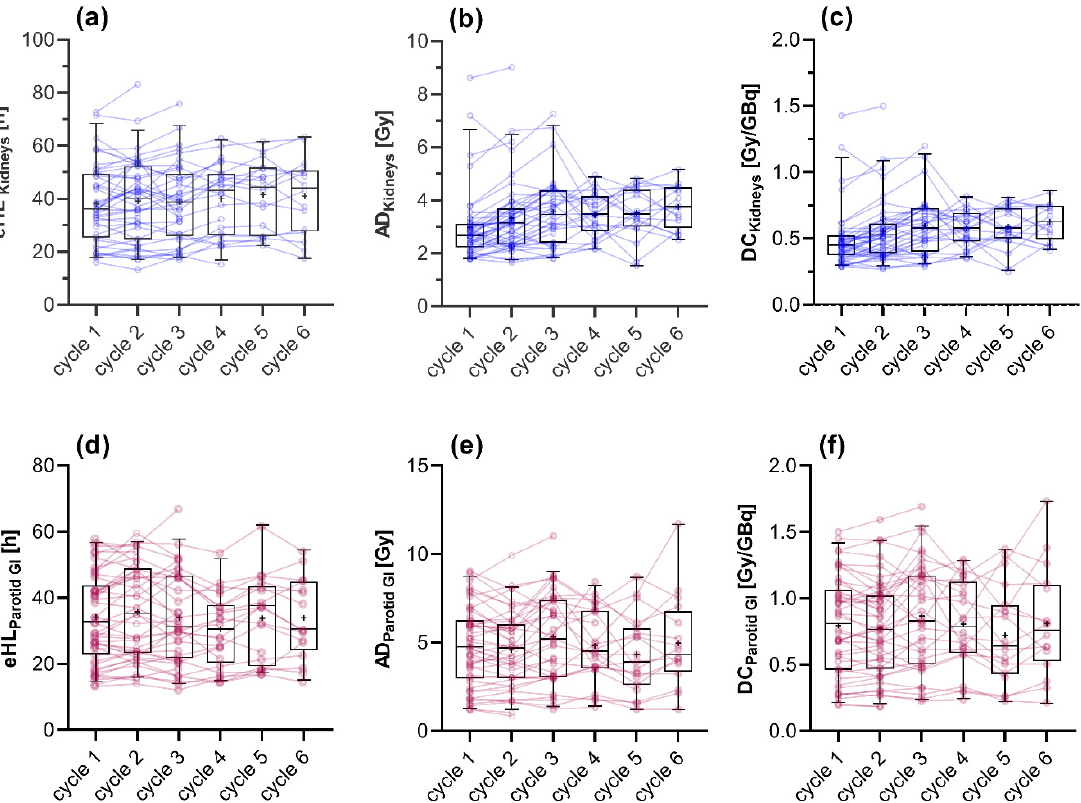
Figure 2. Boxplots showing the quartiles, the 5th and 95th percentiles (whiskers) and the mean (+) of the e ffective half-life ( eHL ), absorbed doses ( AD ) and dose coefficients (DC) for the kidneys ( a – c ) and the parotid glands ( d – f ). The colored dots represent the course of the values for the respective patients.